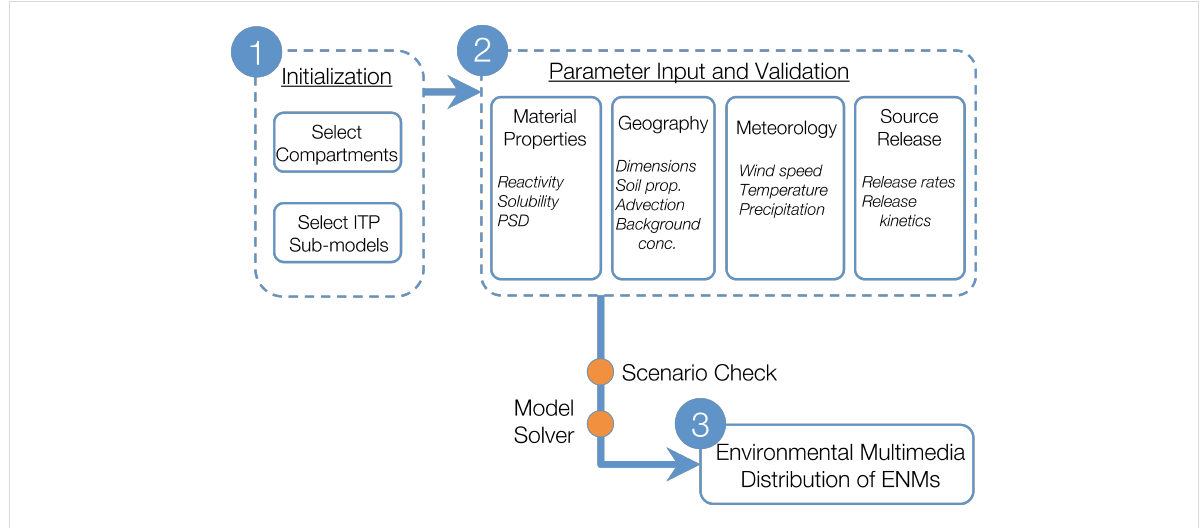
the user. ENM release rates to the various compartments are also required and these can be obtained from LearNano by selecting the target ENM, region, and applications of interest, or specified directly by the user (Figure 6). The temporal profile of the ENM release rate kinetics can be specified as constant or periodic sinusoidal (e.g., to mimic seasonal and diurnal